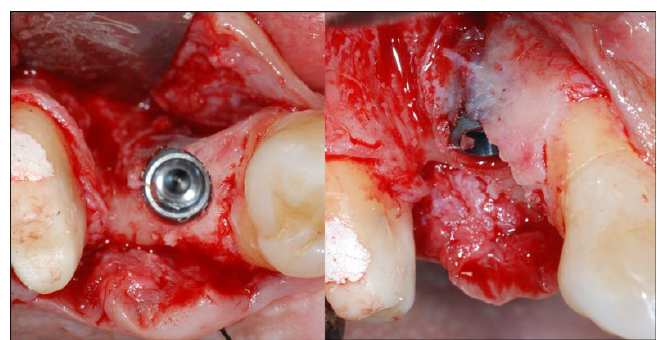
Figure 3. On the left the occlusal view, on the right the vestibular view of the dehiscence of the thin buccal plate after implant insertion.